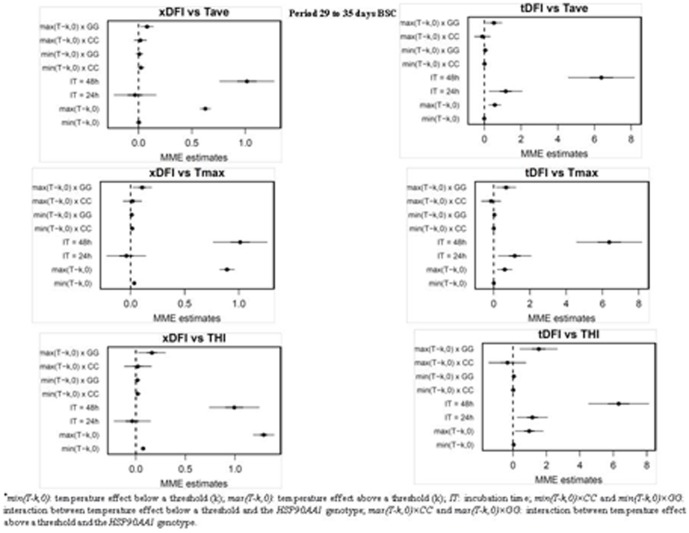
Regression coefficients from the mixed-effects model relating DFI values with summary measure of Tave, Tmax and THI for the days 29 to 35 before semen collection.For each coefficient in the model, estimates (points) plus and minus 1 (bold line) and 2 (thin line) standard deviations are represented. *